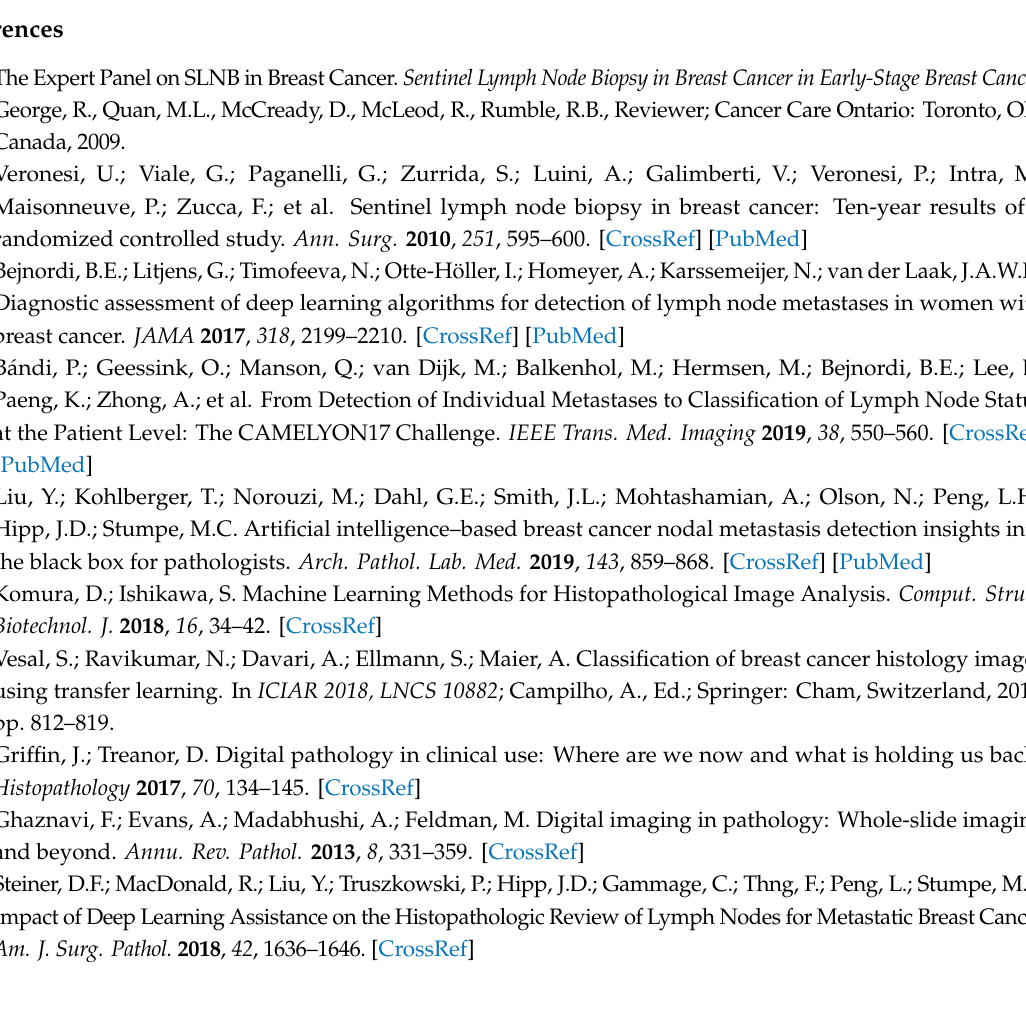
Figure S1: Architecture of baseline model used in this study, Figure S2: U-net structure for image segmentation, Figure S3: Record of training and validation accuracies across epochs for U-nets trained for semantic segmentation, Figure S4: Confusion matrices for models evaluated on the test set, Table S1: Model